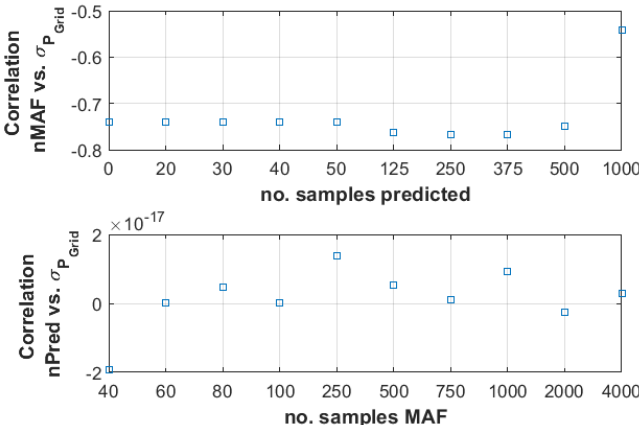
Figure 10. Correlation between the standard deviation of the power injected into the grid and the window length of the moving average filter (MAF) as a function of the number of predicted samples used in the MAF; correlation between the standard deviation of the power injected into the grid and the number of predicted samples used in the MAF as a function of the number of samples considered in the MAF.